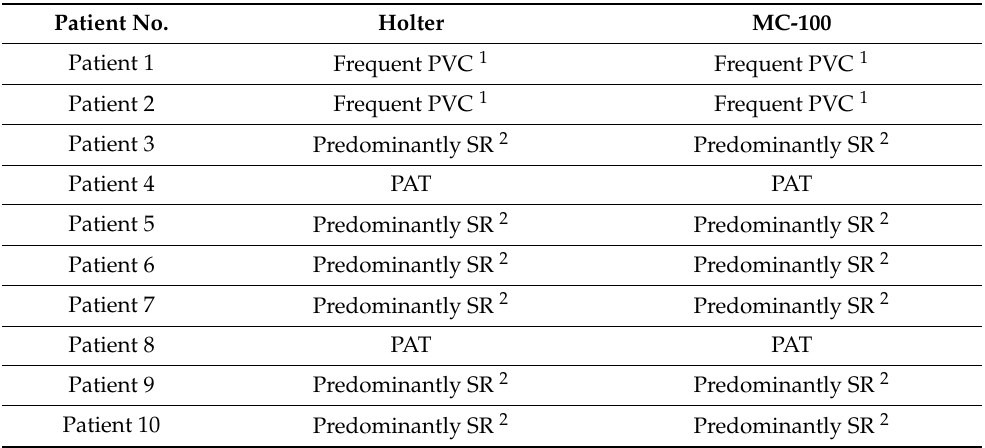
Table 4. Comparisons of diagnoses between Holter and adhesive single-lead ECG monitoring by cardiologists.